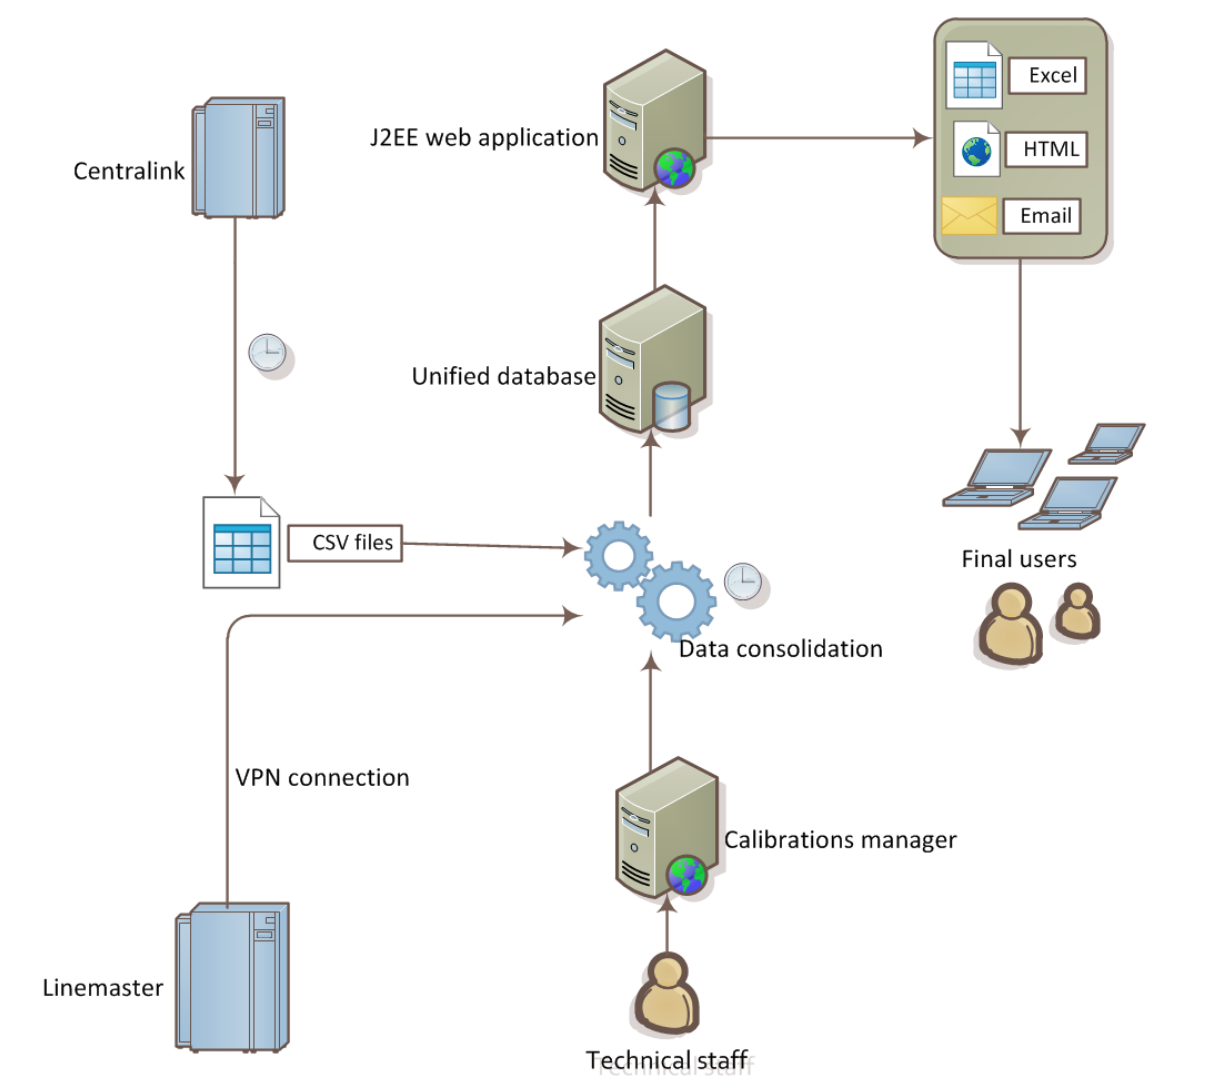
Figure 4. System